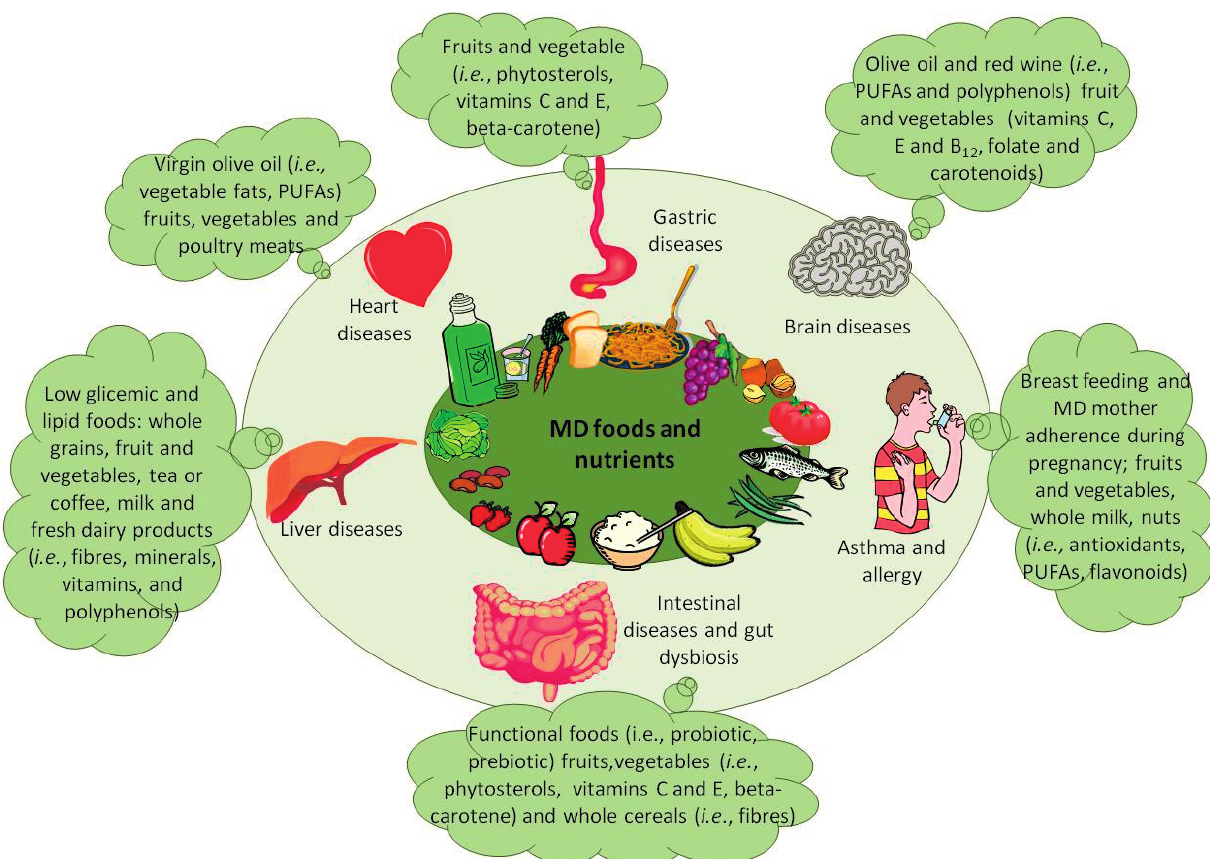
Figure 2. MD-related positive effects on